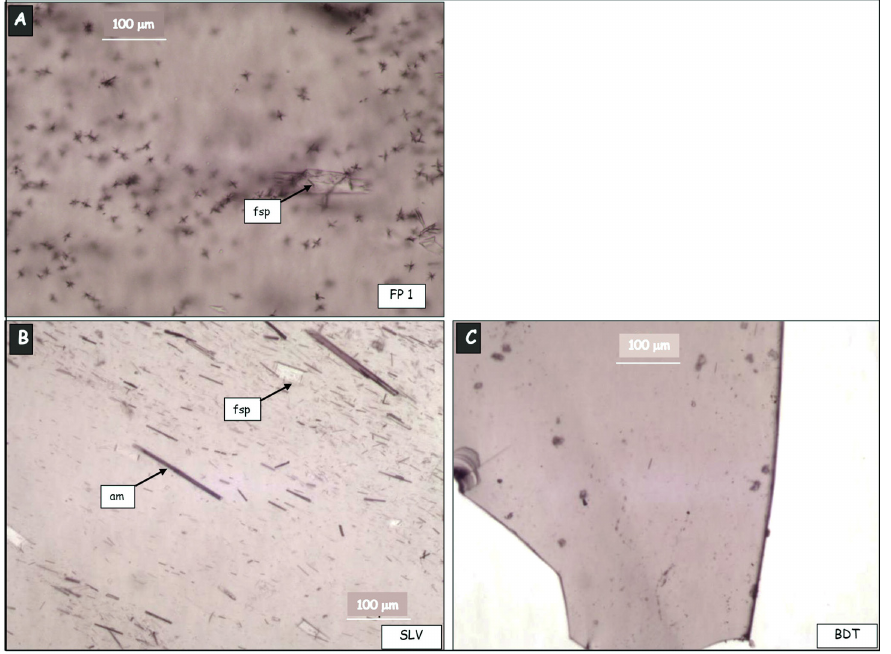
Figure 6: Plane-polarized light microscope photos of obsidian thin sections (magnification 40 X). ( A ) Fossa Pernice 1: feldspar micropheno- crysts and clots of unidentified quench microlites; ( B ) Salto La Vecchia amphibole and feldspar microlites; ( C ) Balata dei Turchi: very rare amphibole and aenigmatite microlites poorly visible in the lower half of the